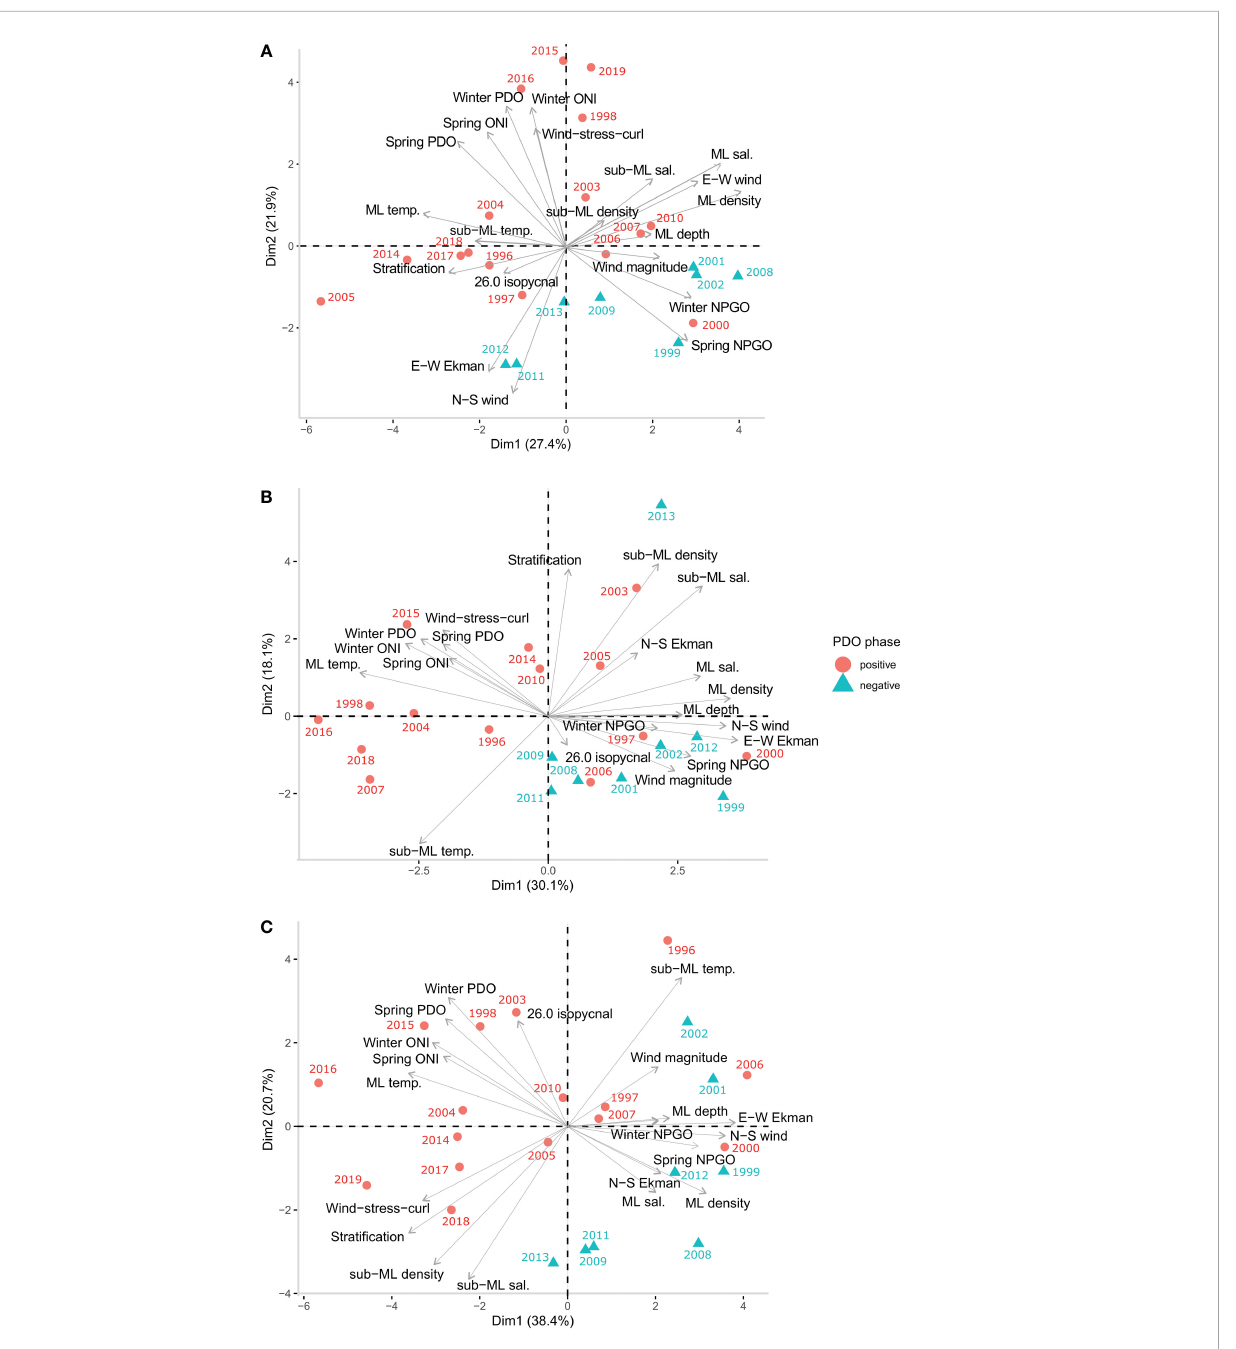
FIGURE 3 Ordination biplots of PC1 and PC2 for each bioregion, (A) South bioregion, (B) North bioregion and (C) Offshore bioregion. Oceanographic and physical covariates are overlaid as (grey) arrows on top of years (annual means) which are coloured according to PDO phase during April, May and June. ML, mixed layer; temp., temperature °C; sal., salinity; N-S, north-south; E-W, east-west; PDO, paci fi c decadal oscillation; ONI, Ocean Niño index; NPGO, north paci fi c gyre